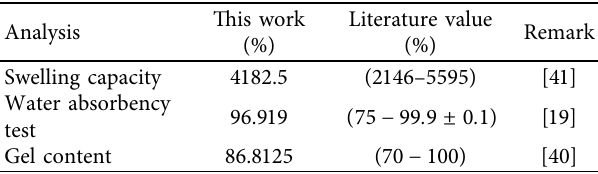
Table 5: Literature-based study for mechanical property study for synthesized